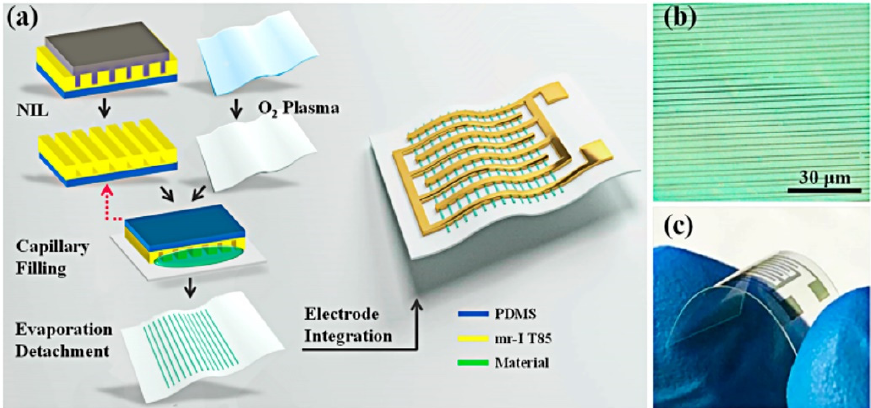
Figure 13. ( a ) Schematic illustration of the preparation process of flexible NW-based sensors under NIL protocol; ( b ) Optical microscope image of the highly aligned PEDOT:PSS NWs; ( c ) Picture of the integrated flexible device. Reproduced from Ref. [188]. Copyright 2019, American Chemical Society.